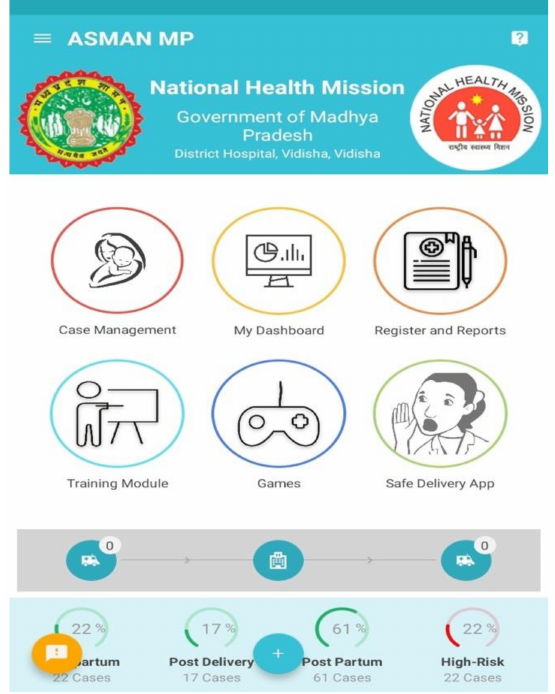
Figure 1. Main interface of the ASMAN (Alliance for Saving Mothers and Newborns)